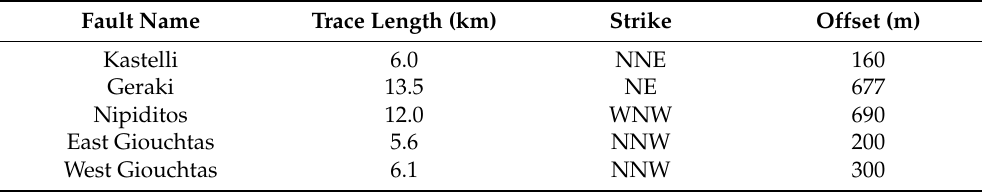
Table 1. Main tectonic features of the faults in the area of the 2021 Arkalochori strong